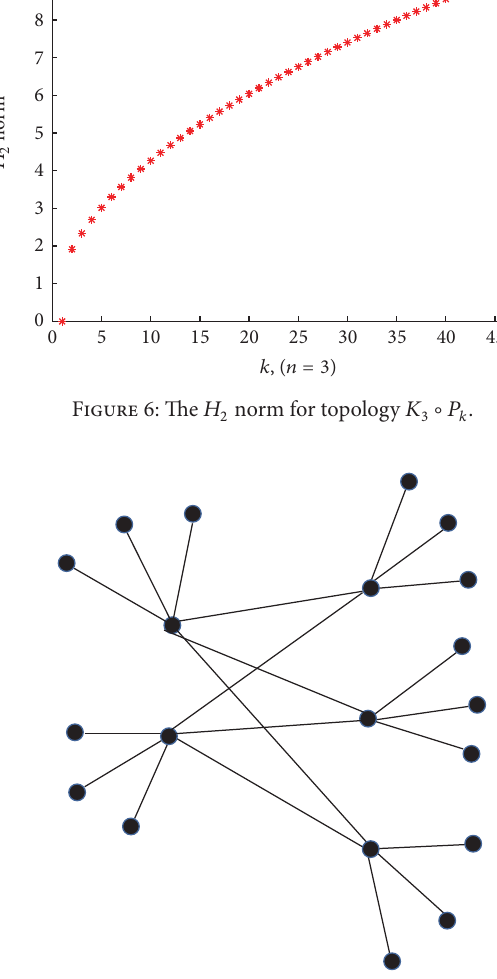
Figure 7: The communication topology 𝐾 2,3 ∘ 𝑃 3